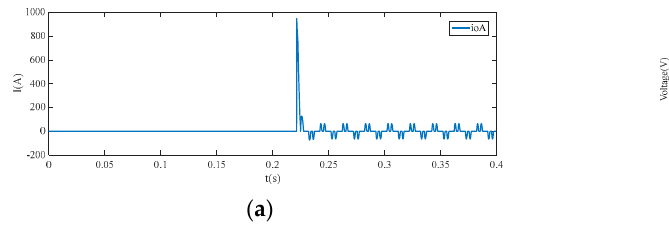
Figure 11. Simulation results of UPS with rectifier load using VSG control strategy and dynamic switching method ( a ) load current of phase A i oA , ( b ) load voltage of phase A U oA , C rc = 5500 µ F, R rc = 16 Ω .